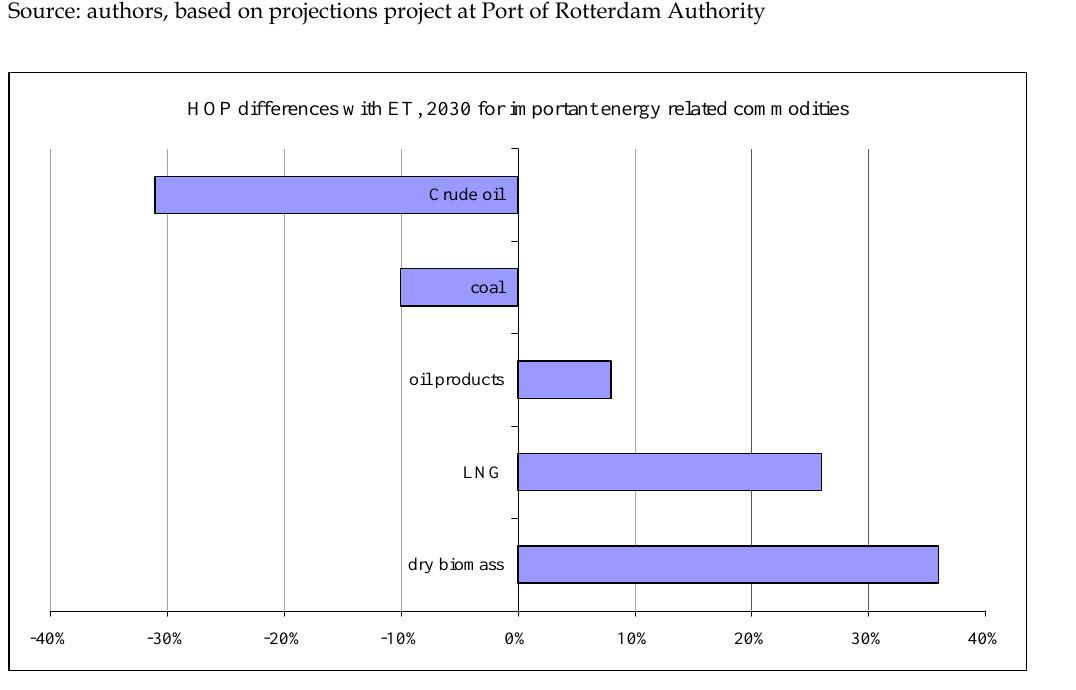
Figure 5. Differences between ET and HOP throughput in 2030, for important energy commodities Source: authors, based on projections project at Port of Rotterdam